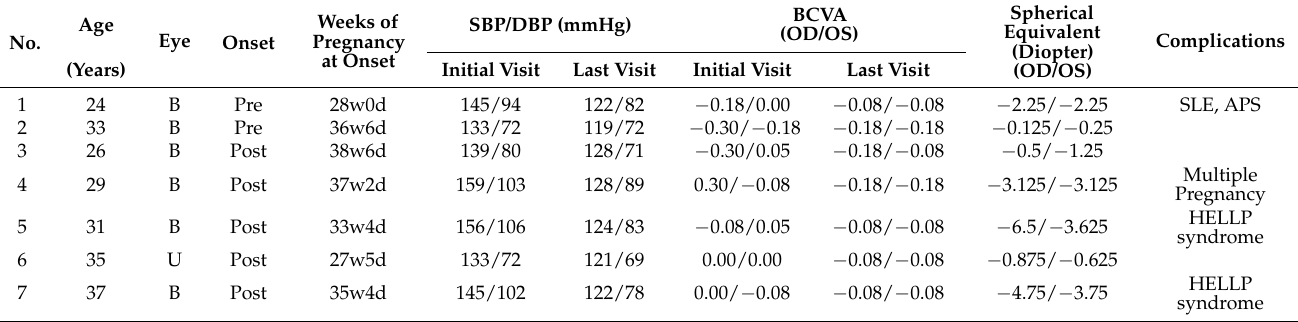
Table 1. Patient characteristics.